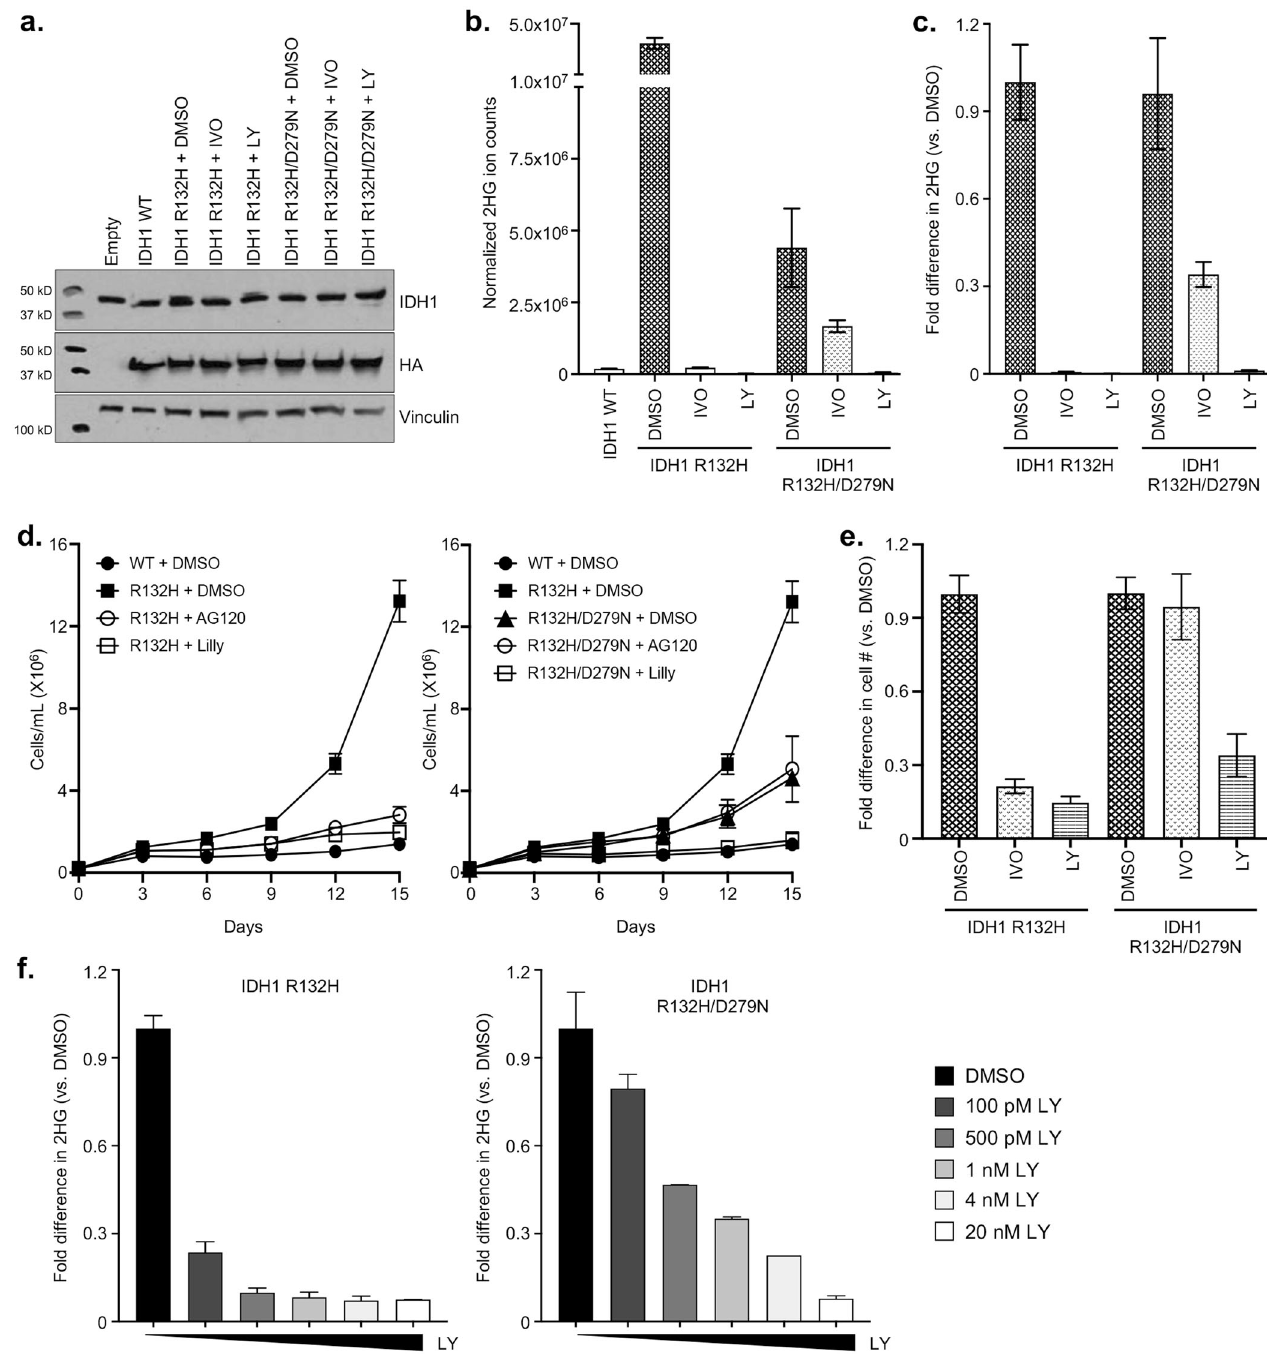
Fig. 3 Characterization of IDH1 R132H/D279N. a Immunoblot analysis of IDH1 expression in TF-1 cells infected with lentivirus expressing the indicated IDH1 variants and treated with vehicle-control (DMSO), 500 nM ivosidenib (IVO), or 500 nM LY3410738 (LY), as indicated. b , c Quanti fi cation of (R) -2HG ( b ) and fold-change in (R) -2HG ( c ) in the TF-1 cell lines shown in a , as indicated. Shown are mean values (±SD) of duplicate experiments. d , e Proliferation under cytokine-poor conditions ( d ) and fold-change in day 15 cell counts ( e ) of the TF-1 cells shown in ( a ) The mean (±SD) cell counts of three replicates is shown. f Fold-change in intracellular (R) -2HG in TF-1 cells expressing IDH1 R132H (left) or IDH1 R132H/D279N (right) treated overnight with the indicated concentrations of LY3410738. Shown are mean values (±SD) of duplicate experiments. In all cases, representative results from at least two independent experiments are